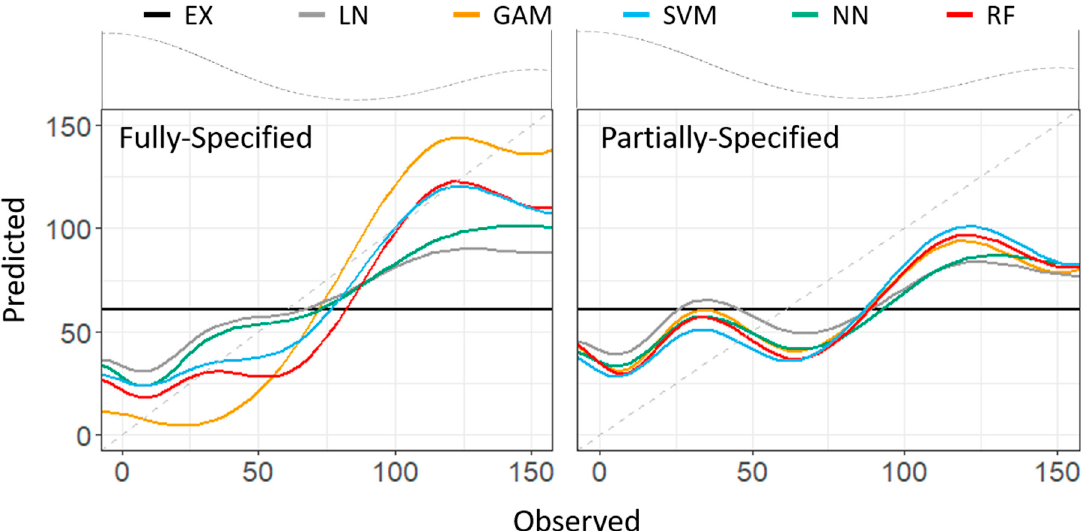
Figure 8. Smoothed trend of nonlinear response surface predicted values ( y -axis) versus observed ( x -axis) values for design and model-based estimators calibrated using generalized random tessellation stratified designs (GRTS) and image bands 1–4 (Fully-Specified) and image bands 1–3 (Partially-Specified) as predictor variables. Introduced noise into the nonlinear response surface was held constant at 40% of the nonlinear SC1 surface standard deviation. Sample size was held constant at 50 for each of the 100 iterations used in the study. The gray dashed lines within Fully-Specified and Partially-Specified graphs serve as a one-to-one reference line while the gray dotted lines above the graphs depict relative frequency of each observed value. Ex = expansion; LN = linear; GAM = general additive model; SVM = support vector machine; NN = neural networks; RF = random forests.